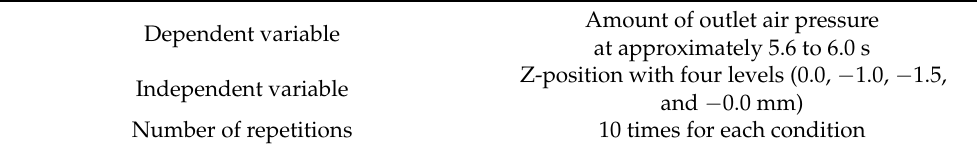
Table 4. Experimental setup to determine effect of z-position on the pick-up operation.